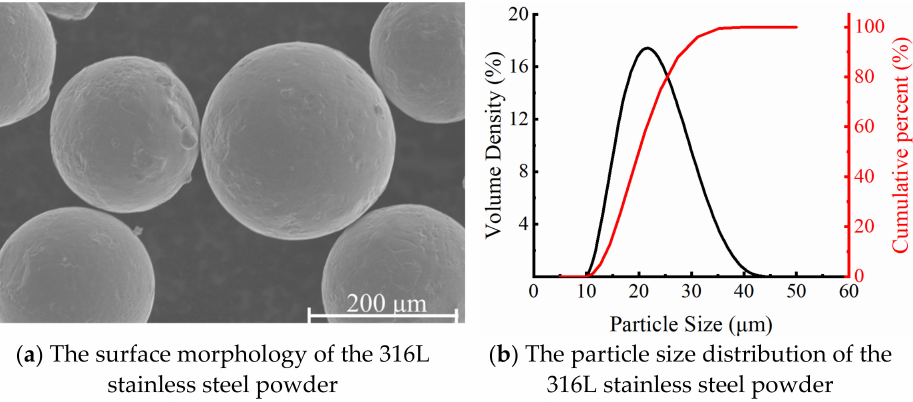
Figure 1. The surface morphology and particle size distribution of the 316L stainless steel